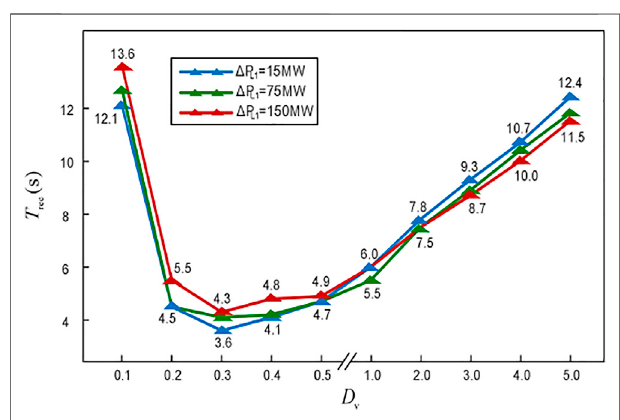
FIGURE 9 | Variation in T rec with respect to D v .